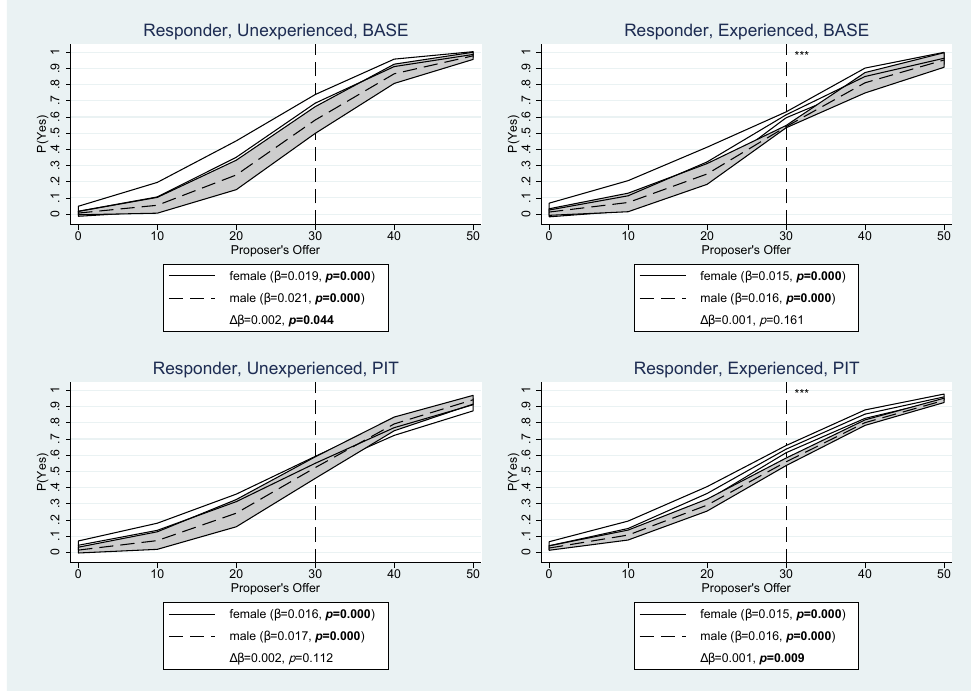
Figure 5. Responder Voting Behavior: Proposer’s Offer. The graphs show the responder’s average probability to vote “yes” on a certain offer in tokens by experience, treatment, and gender. β and ∆ β are the marginal effect of the proposer’s offer and the differential slope of Gender { 1 = male } estimated by a random effects probit panel regression. p is the significance level. Shaded areas represent 90% confidence intervals around the mean. Significance levels for a χ 2 test on the hypothesis that female and male responders exhibit the same probability to vote “yes” on a proposal of 30 tokens are given by asterisks in the graphs: * p ≤ 0.10, ** p ≤ 0.05, *** p ≤ 0.01 (see Table A6 in Appendix